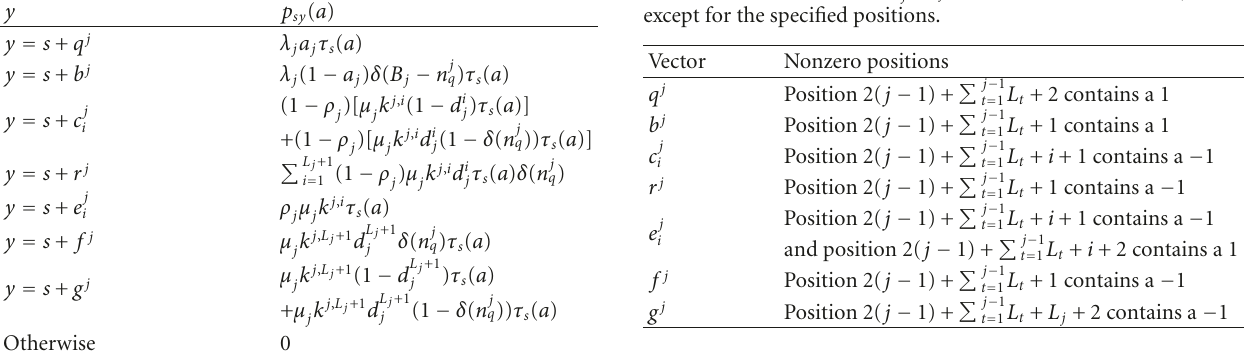
Table 2: Expression of transition probability p sy . Table 3: Definition of vectors in Table 2: each vector defined in this